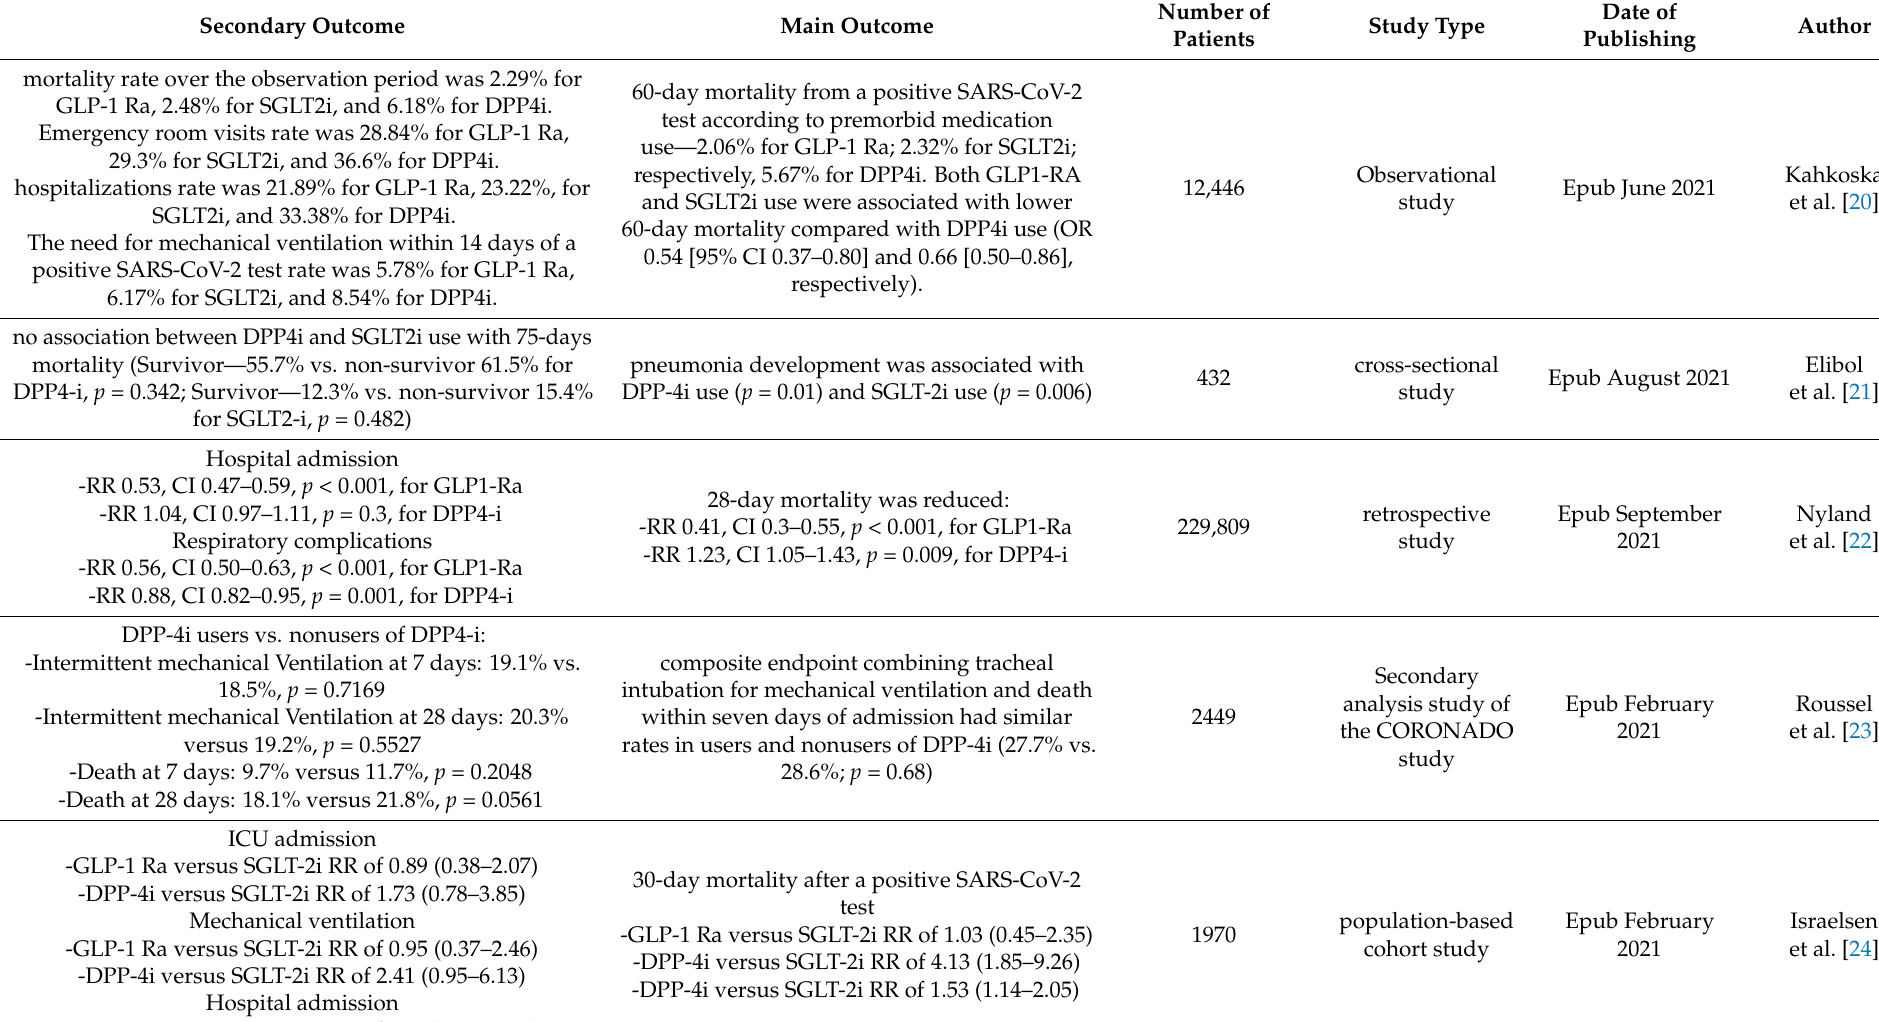
Table 1. Summary of papers evaluating the association between COVID-19 clinical outcomes and DPP-4i, SGLT-2i, and GLP-1 Ra